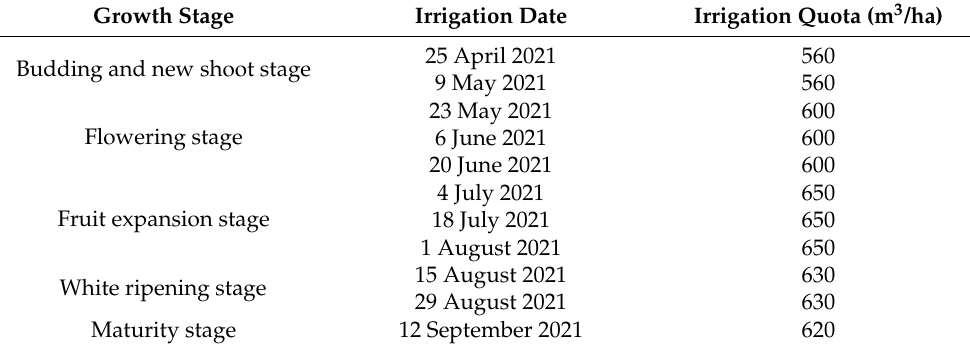
Figure 4. Schematic diagram of jujube planting mode. Table 3. Irrigation schedule during the jujube growing season in 2021.